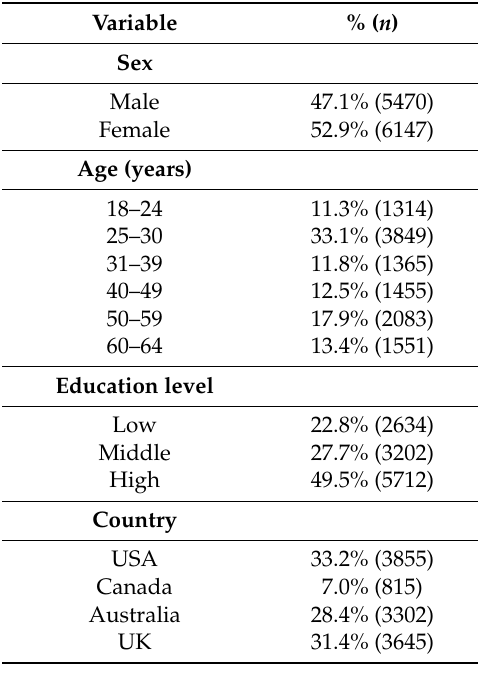
Table 1. Sample characteristics ( n = 11,617).